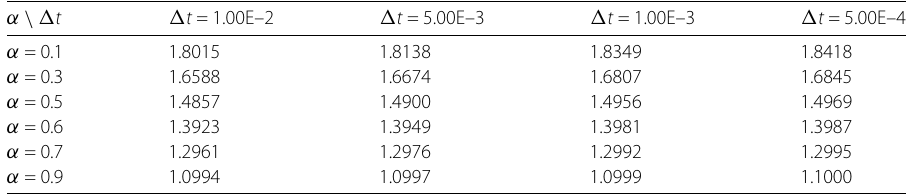
Table 2 Temporal convergence orders of w for Example 4.1